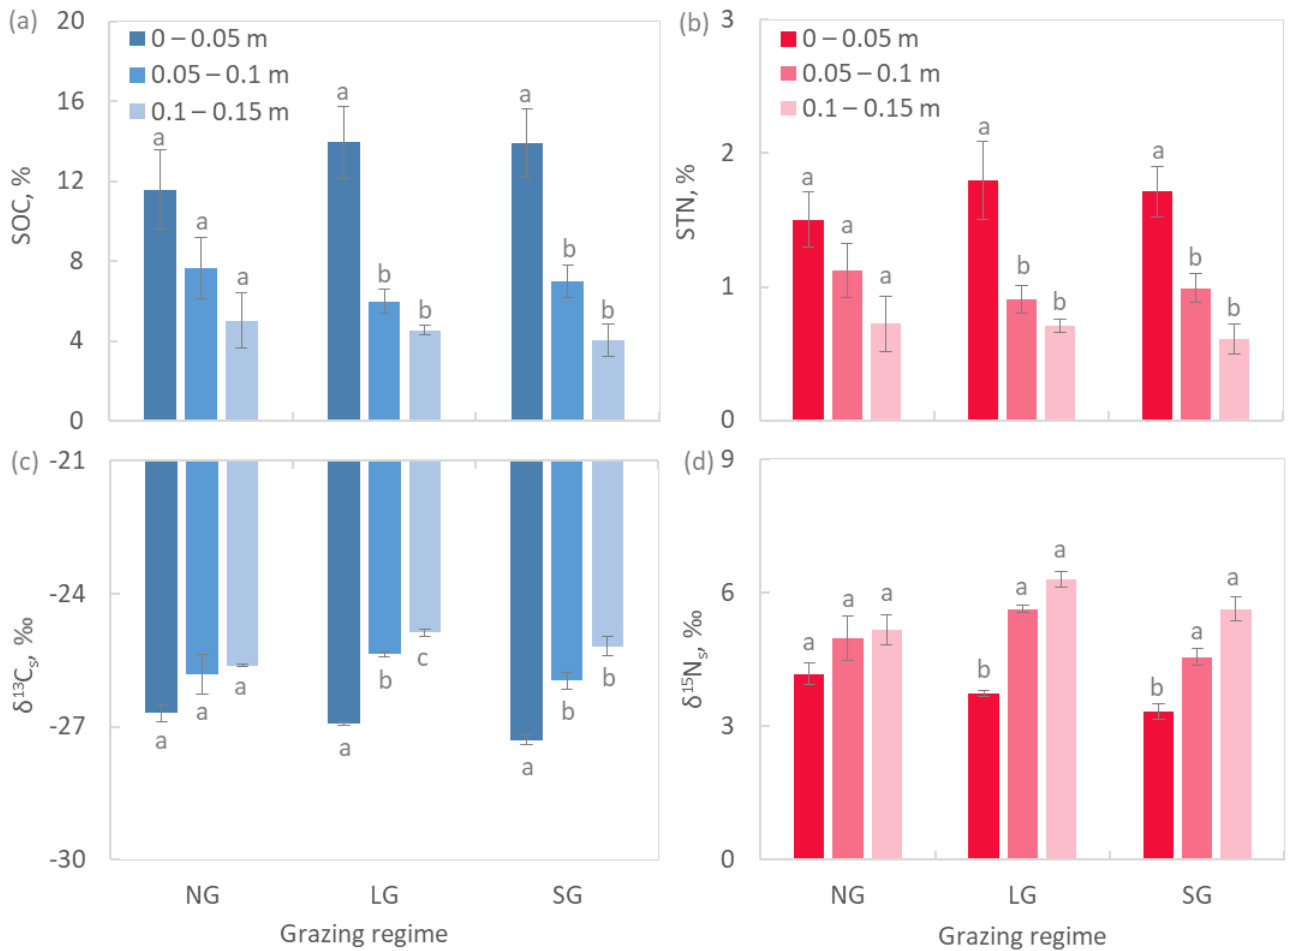
Figure 5. Depth distribution of ( a ) soil organic C (SOC); ( b ) total soil N (STN); ( c ) soil δ 13 C ( δ 13 C s ) and ( d ) soil δ 15 N ( δ 15 N s ) in grazed and non-grazed plots (mean ± standard error). Letters next to the bars show the significance of ANOVA at p <